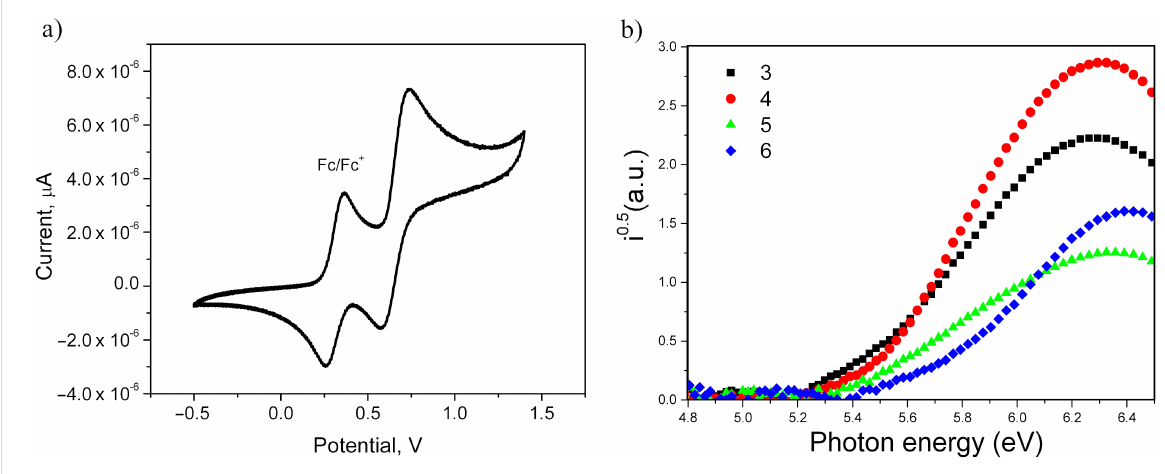
Figure 4: a) Cyclic voltammogram of derivative 3 in dichloromethane (a three-electrode cell consisting of a platinum coil as counter electrode, a glassy carbon working electrode, and a silver wire as reference electrode was used; sweep rate – 100 mV/s, 0.1 M solution of tetrabutylammonium hexafluorophosphate ( n -Bu 4 NPF 6 )) and b) photoelectron emission spectra of the layers of derivatives 3 – 6 .